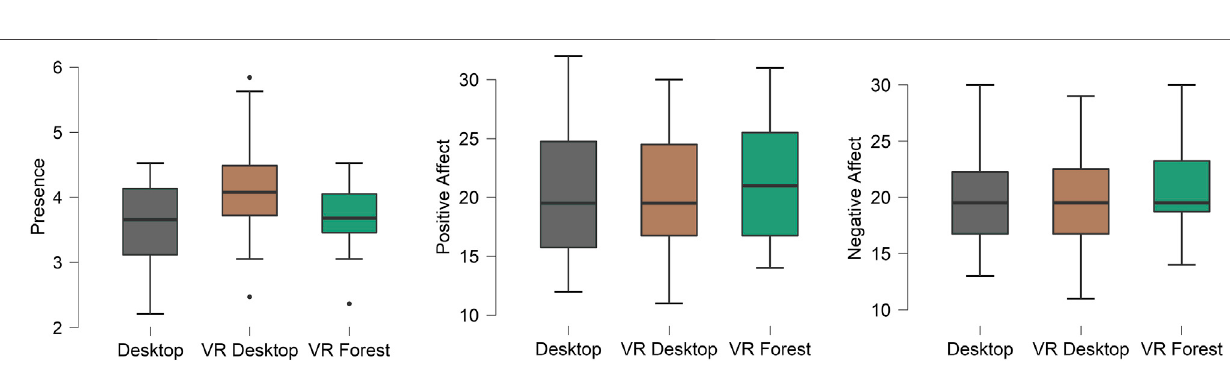
Frontiers in Virtual Reality |